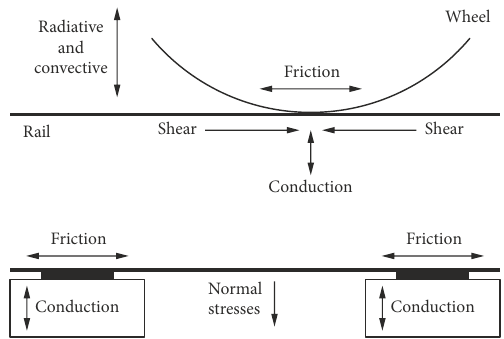
Wheel RailRadiative and convective Friction Shear Shear Conduction ConductionFriction ConductionFriction Normal Figure 6. Sources of heat in a wheel–rail–sleeper interaction